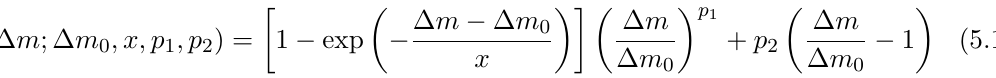
( ) Figure 5 . Result of the simultaneous (cid:12)t to B ! D (cid:3)(cid:6) (cid:22) (cid:7) ( ) (cid:23) (cid:22) , D (cid:3)(cid:6) ! decays with downstream K 0 candidates, in 2016 data. The projections of the (cid:12)t result are shown S for (left) m ( K 0 (cid:25) + (cid:25) (cid:0) ) and (right) (cid:1) m . The (blue) total (cid:12)t PDF is the sum of components describing S (solid red) signal, (dashed black) combinatorial background and (dotted green) random soft pion